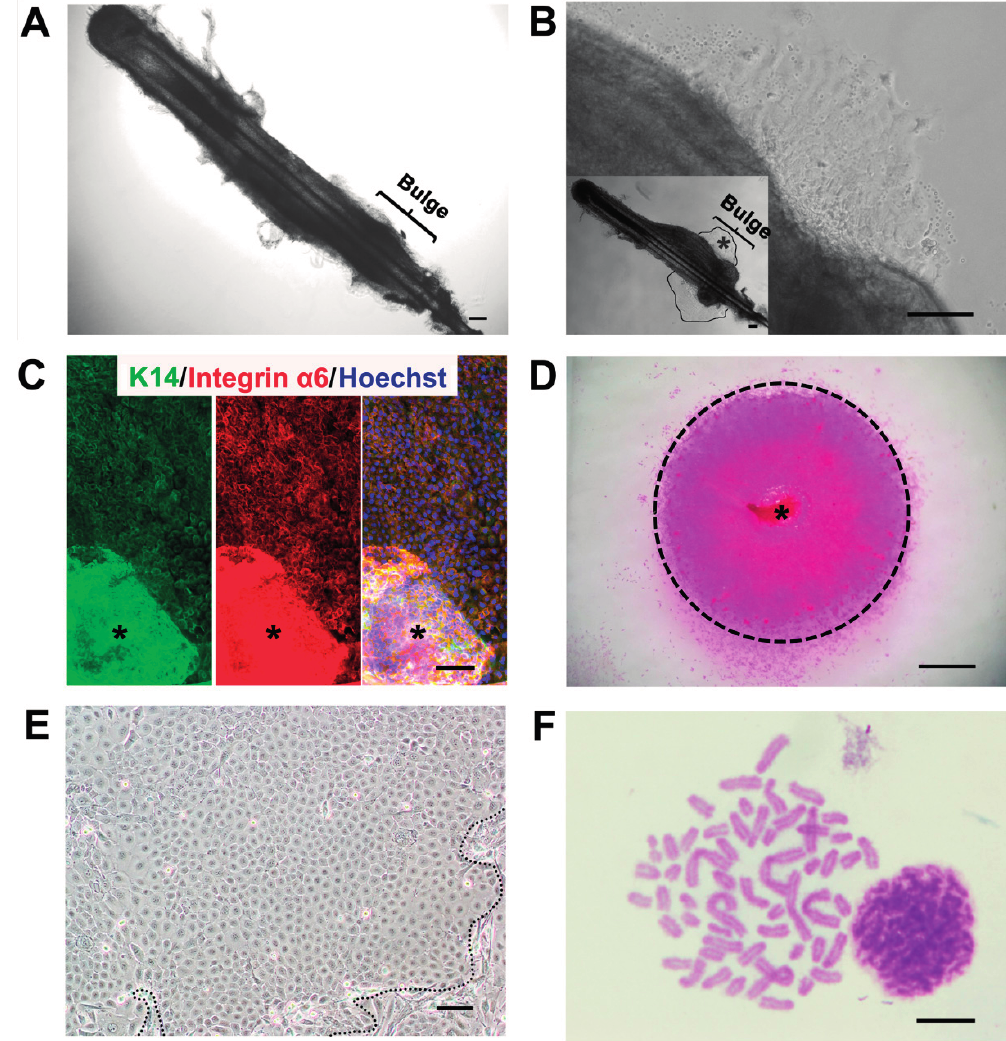
Figure 1. ( A ) A freshly-isolated ovine vibrissa hair follicle. The bugle area is illustrated; ( B ) The cell colony derived from the bulge of the same ovine vibrissa hair follicle after three days of culture. In the bottom-left box, the area within the lines indicates the initial keratinocyte colony. The asterisk indicates the corresponding area shown in ( B ); ( C ) K14 and integrin α 6 immunostaining of keratinocytes that migrated from the bulge. The asterisk indicates the bulge; ( D ) A Rhodamine B-stained keratinocyte colony formed around the hair follicle after nine days in culture. The asterisk indicates the vibrissa hair follicle; ( E ) A part of a colony of the ovine bulge-derived keratinocytes and surrounding feeder cells (outside the dashed lines) after passaging; ( F ) Karyotype (57, XX type sex chromosome) of a representative ovine bulge-derived keratinocyte at Passage 15. For ( A – C , E ), the scale bar is 100 μ m; for ( D ), the scale bar is 1 mm; for ( F ), the scale bar is 10 μ